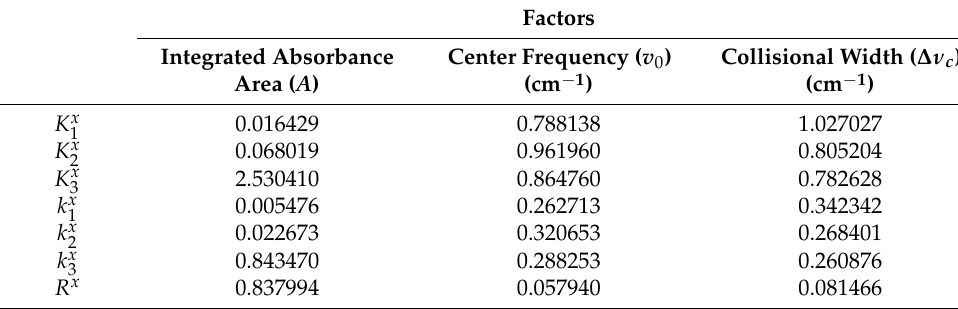
Table 3. Analysis of the orthogonal